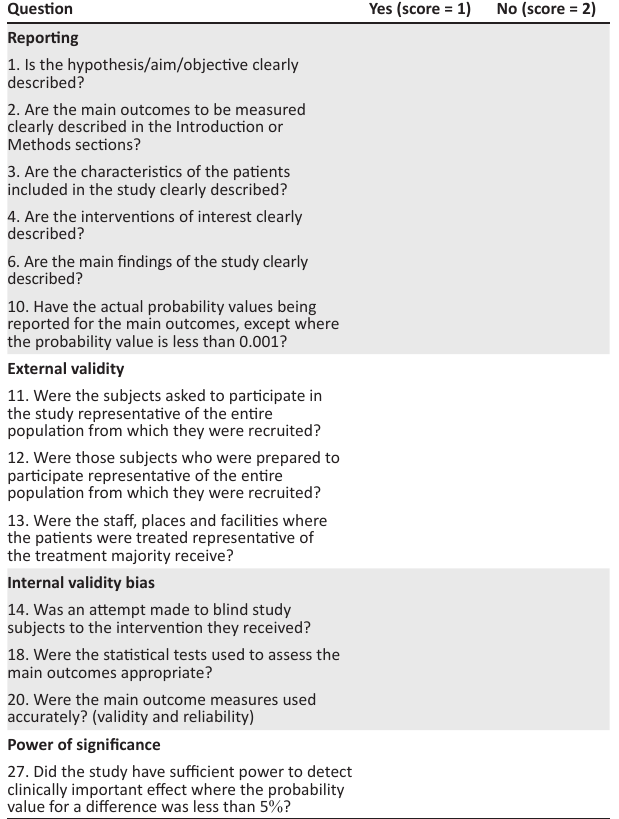
TABLE 1: The questions in the modified Downs and Black Appraisal Scale.